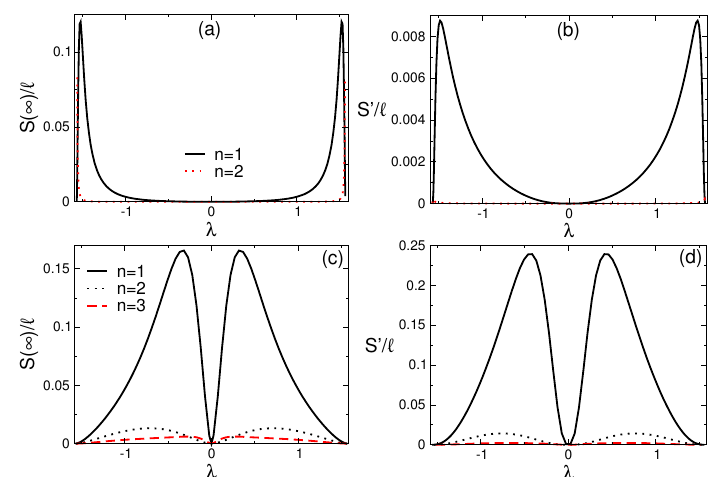
Figure 5: Quasiparticle contribution to the stationary entanglement entropy density S ( t = ∞ ) /(cid:96) and to the entanglement production rate S (cid:48) ( t ) /(cid:96) as function of the quasiparticle rapidity. In all panels the different curves correspond to bound states (strings) of different size n = 1,2,3. Panels (a)(b) show the results for the quench from the tilted ferromagnet with tilting angle ϑ = π/ 10 and chain anisotropy ∆ = 2. Notice in both cases the peaks at λ ≈ ± π/ 2, which signal a large contribution of the slow quasiparticle to the entanglement dynamics. Panels (c)(d) show results for the quench from the Néel state in which the largest contributions correspond to λ with small, but non-zero, value. Similar results are obtained for the quench from the dimer state and the tilted Néel. The contribution of the bound states with n > 1 are always much smaller than that for n =